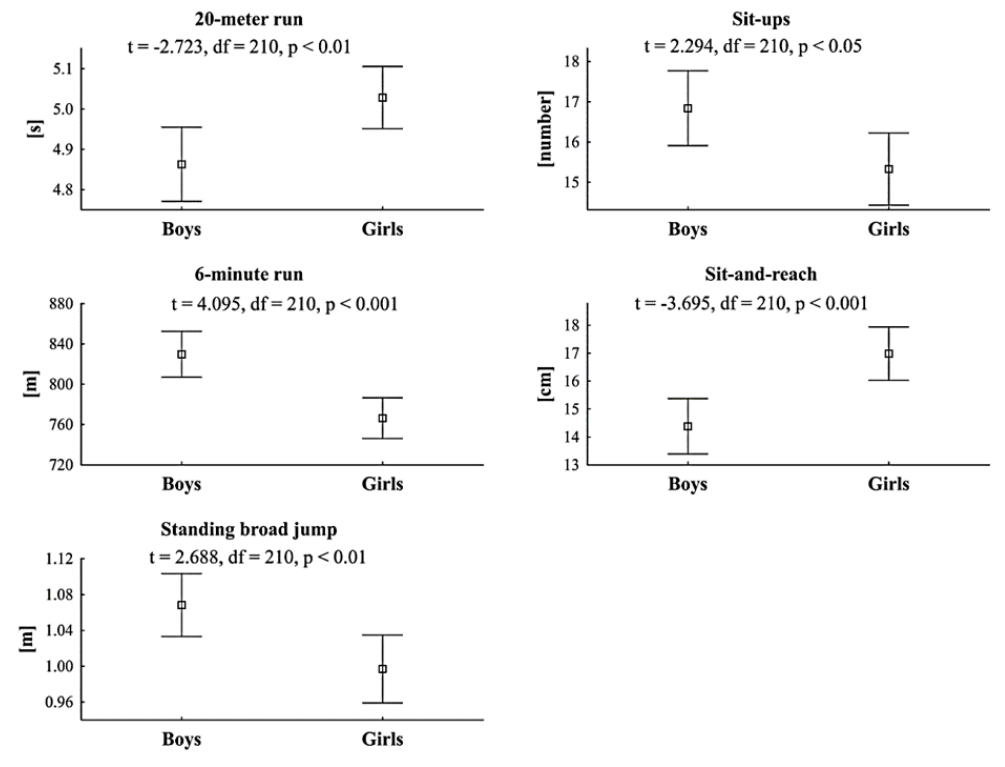
Figure 1. Di ff erences between boys and girls in the results of physical fitness tests (boys, n = 100; girls, n = 112).